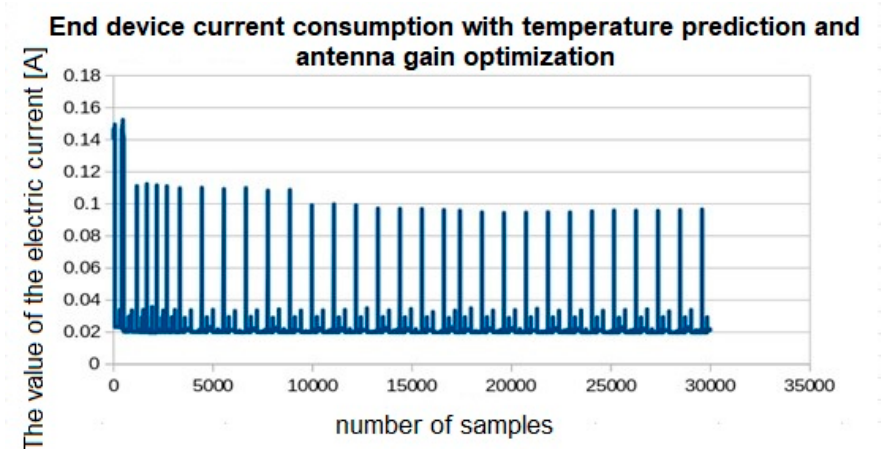
Figure 11. Graph of electricity consumption of the end device using antenna gain optimization and temperature prediction.